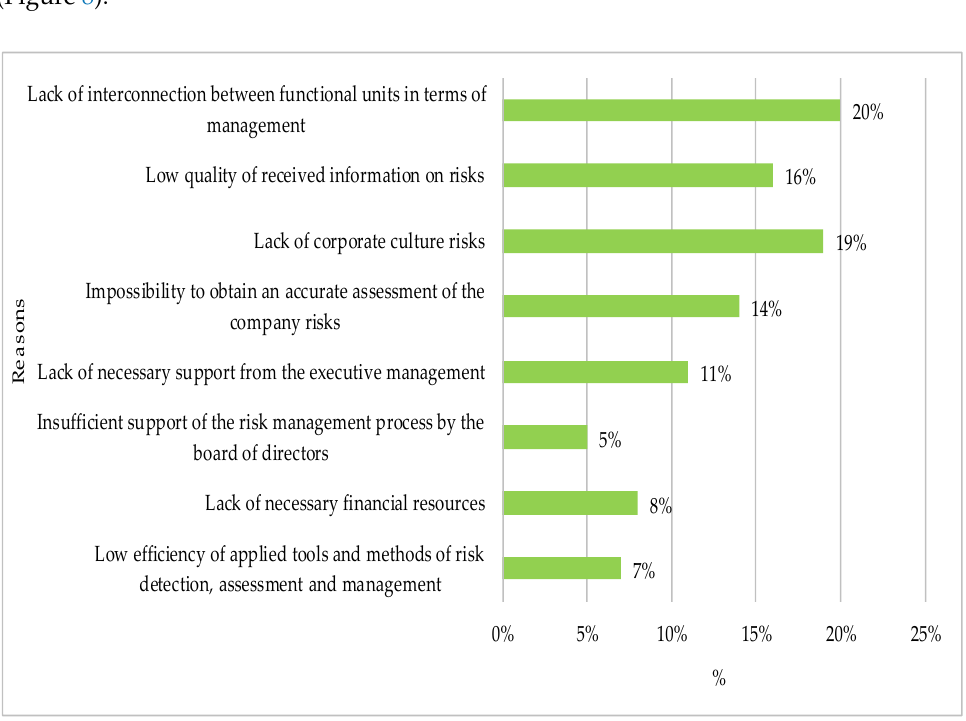
Figure 8. Obstacles to effective risk management in 50 Polish companies. Source: authors’ study.